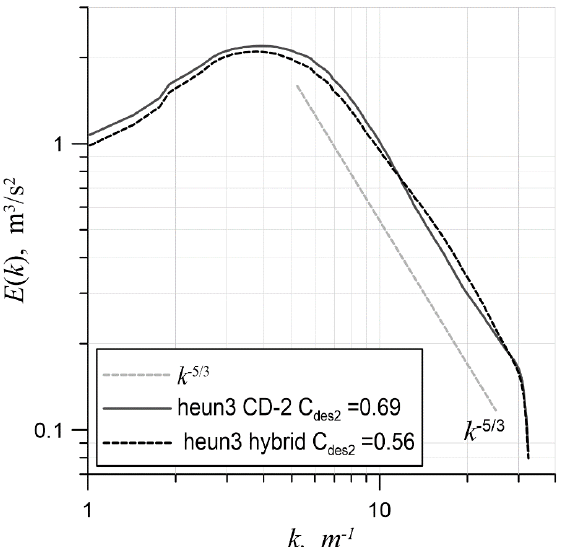
C (0.69 for CD-2 and 0.56 for the hybrid 2 DES